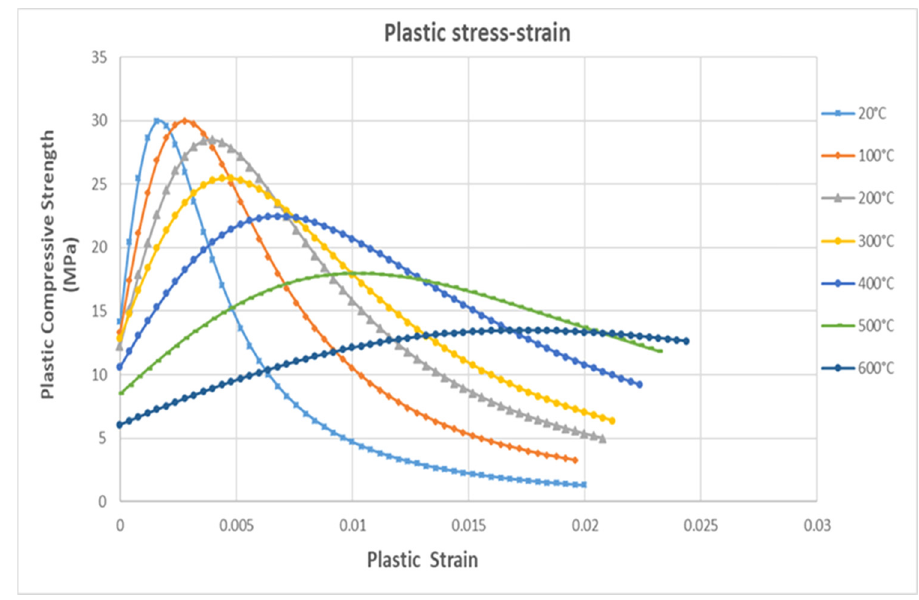
Figure 2: CDP stress – strain curves of the concrete at di ff erent temperatures [ 16 ] .